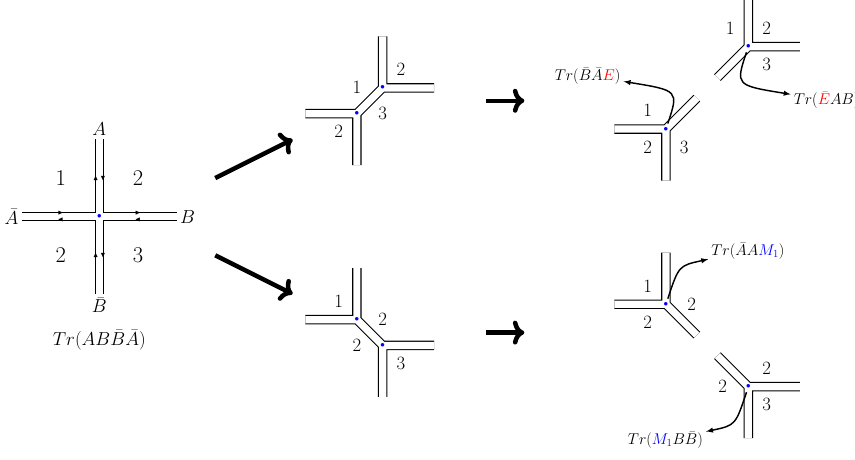
Figure 18 . Adding an extra intermediate edge.